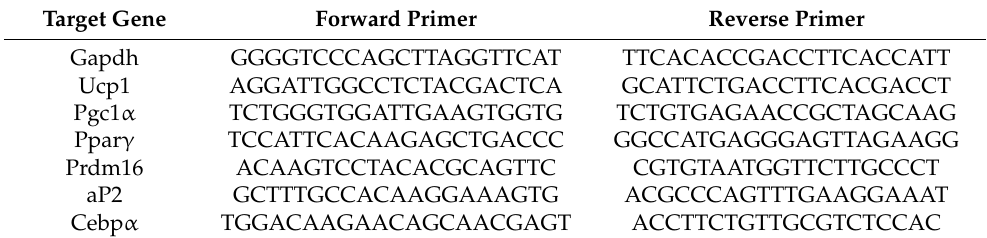
Table 1. List of primers (sequence 5 (cid:48) → 3 (cid:48) ) used for qPCR. Target